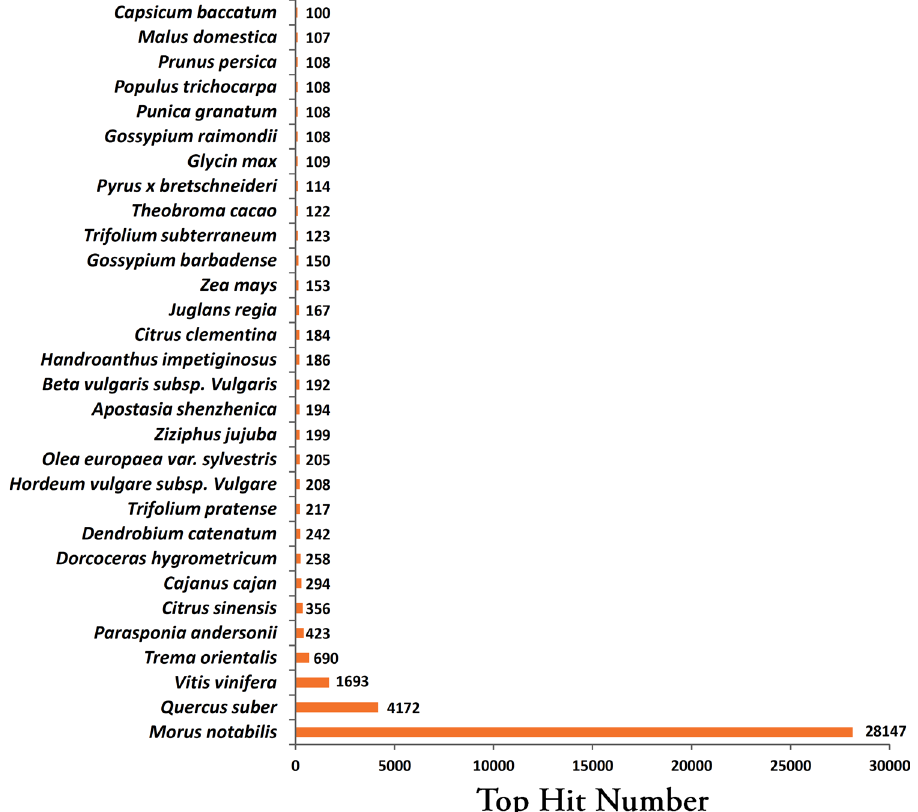
Figure 4. Top hits organism distribution of transcriptome annotation with plantNR